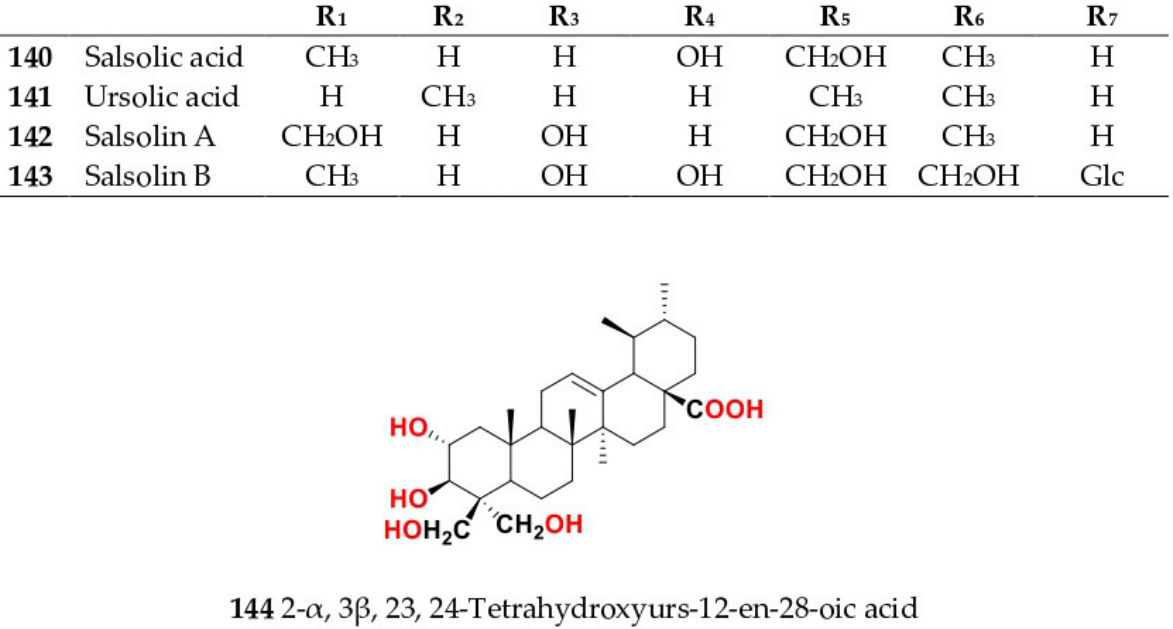
Figure 11. Chemical structure of terpenoid compounds isolated from genus Salsola.